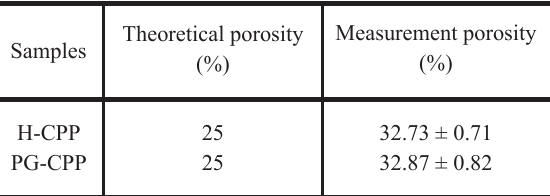
Porosity of the both types of